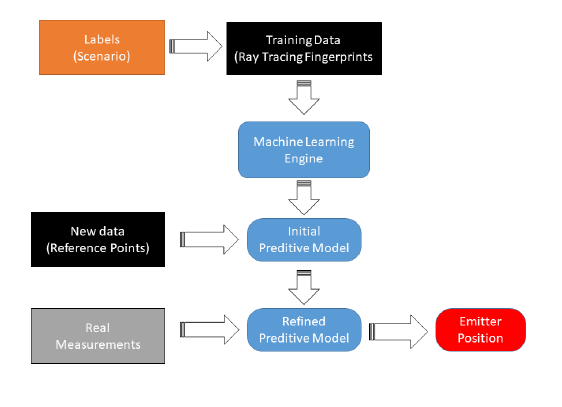
Figure 14. Machine learning framework based on RT